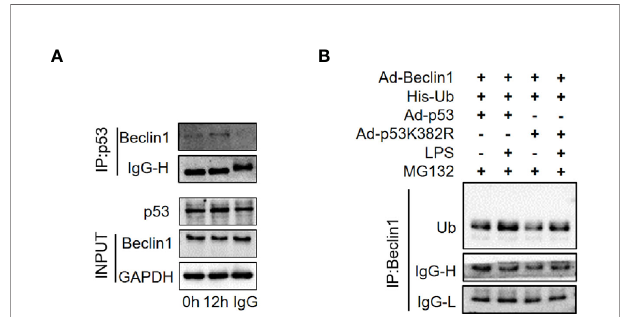
FIGURE 10 | The interaction of p53 and Beclin1 in HK-2 cells. (A) Association of Beclin1 with p53 in the HK-2 cells. The interaction between p53 and Beclin1 was determined by Co- immunoprecipitation assays. (B) Determination of the ubiquitination of Beclin1. Ad-Beclin1 and His-tagged ubiquitin protein and Ad-p53 or Ad-p53K382R were individually transfected into HK-2 cells with or without LPS stimulation. LPS, lipopolysaccharide.